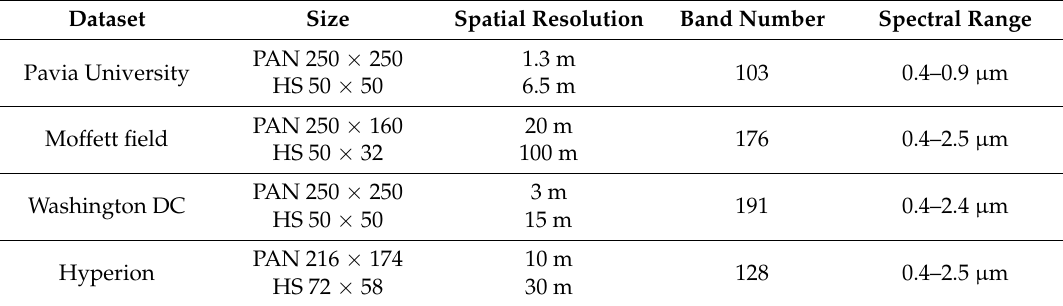
Table 1. Characteristic of the four used